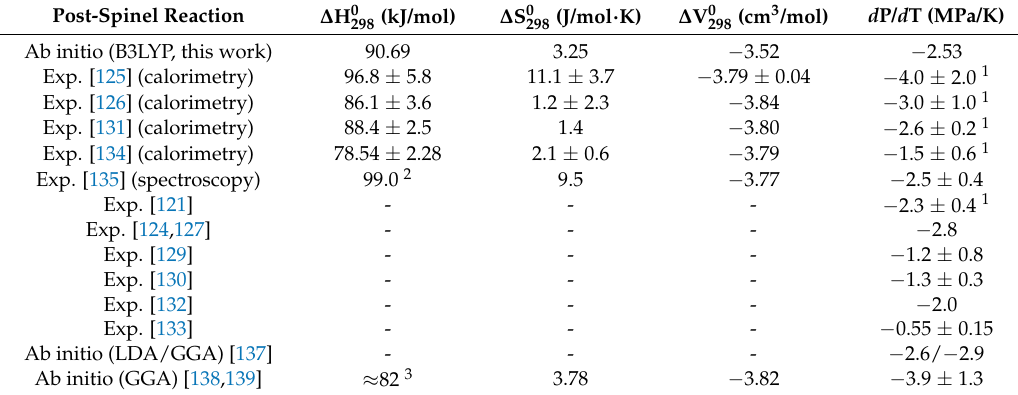
), entropy ( ∆ S 0 ) and volume change ( ∆ V 0 298 298